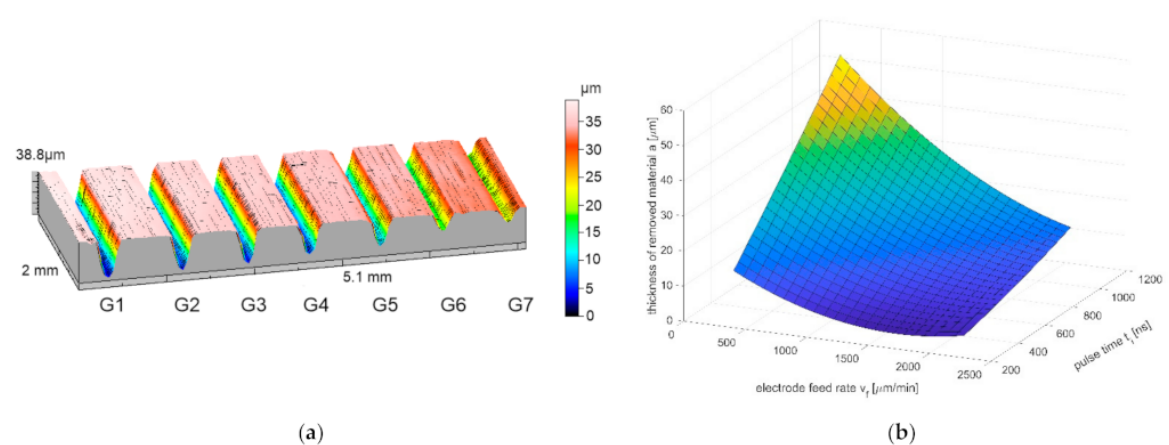
Figure 12. Three-dimensional image of the surface of the sample ( a ) (G1–G5: repeatable 1500 µ m/min, t i = 540 ns, U = 20 V, S 0 = 30 µ m; G6: v f = 1125 µ m/min, t i = 310 ns, U = 15 V, S 0 = 20 µ m; G7: v f = 1125 µ m/min, t i = 310 ns, U = 25 V, S 0 = 40 µ m) and the relation between thickness of the removed material in a single electrode pass a , the feed rate of the electrode v f and the working pulse time t i ( b ) (the size of initial interelectrode gap S 0 = 30 µ m, interelectrode voltage U = 20 V).